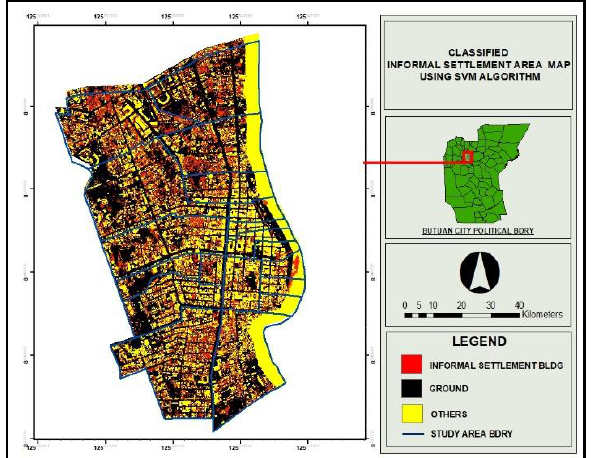
Figure 3. Informal Settlement in Brgy. Limaha